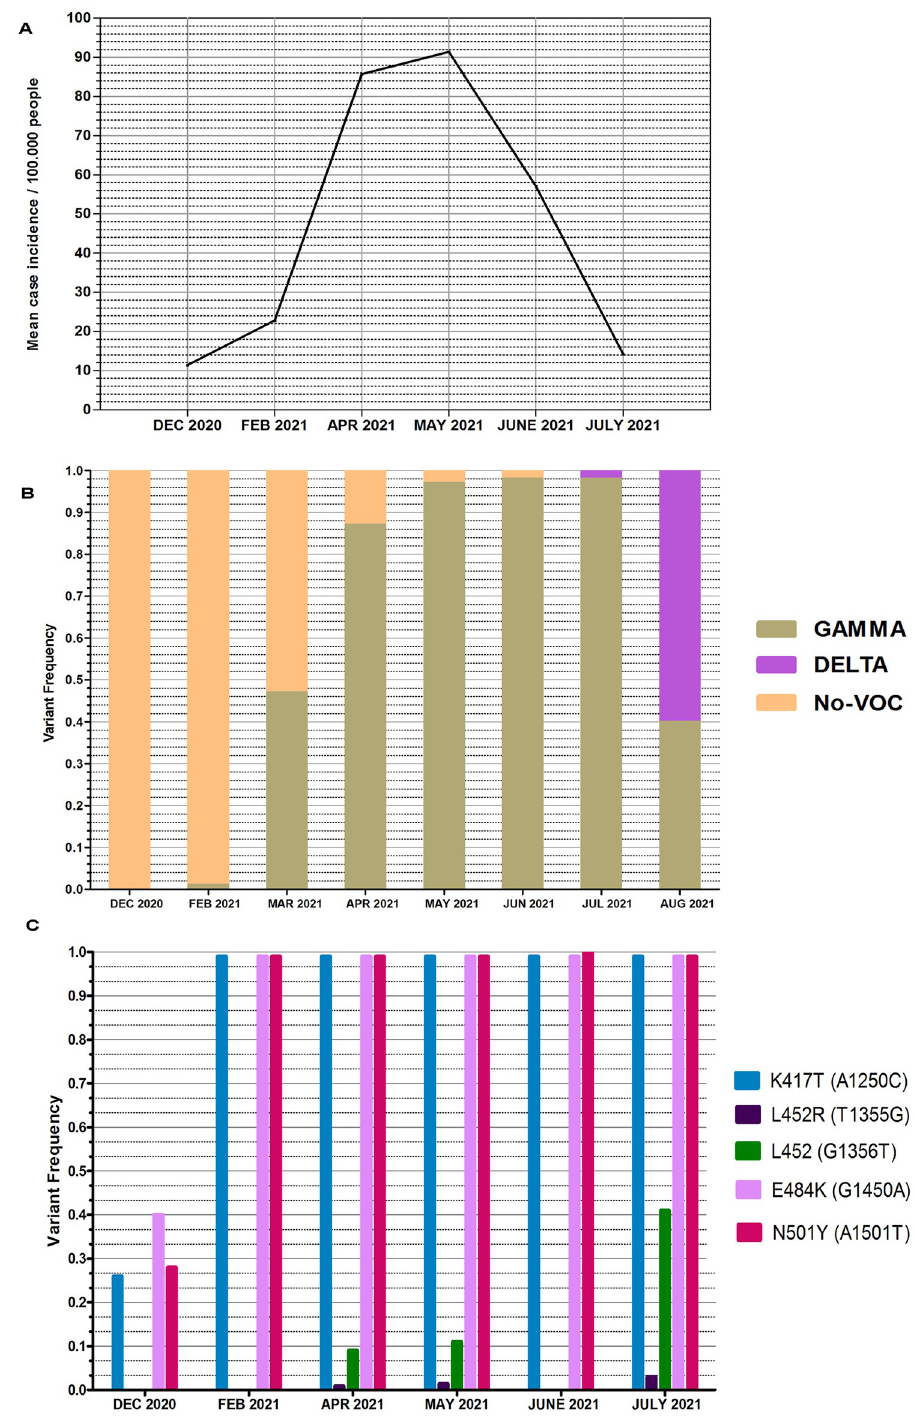
Fig 1. Sampling timeline from Rivera city between December 2020 to July 2021. A ) Mean case incidence per 100,000 people from December 2020 to July 2021. B ) Variant frequency of Gamma, Delta and No-VOC variants in Uruguay between December 2020 and November 2021 according to published epidemiological data. (Ministerio de Salud Pu´blica, 2022). C ) Variant frequency of the amino acid changes identified in each wastewater sample.